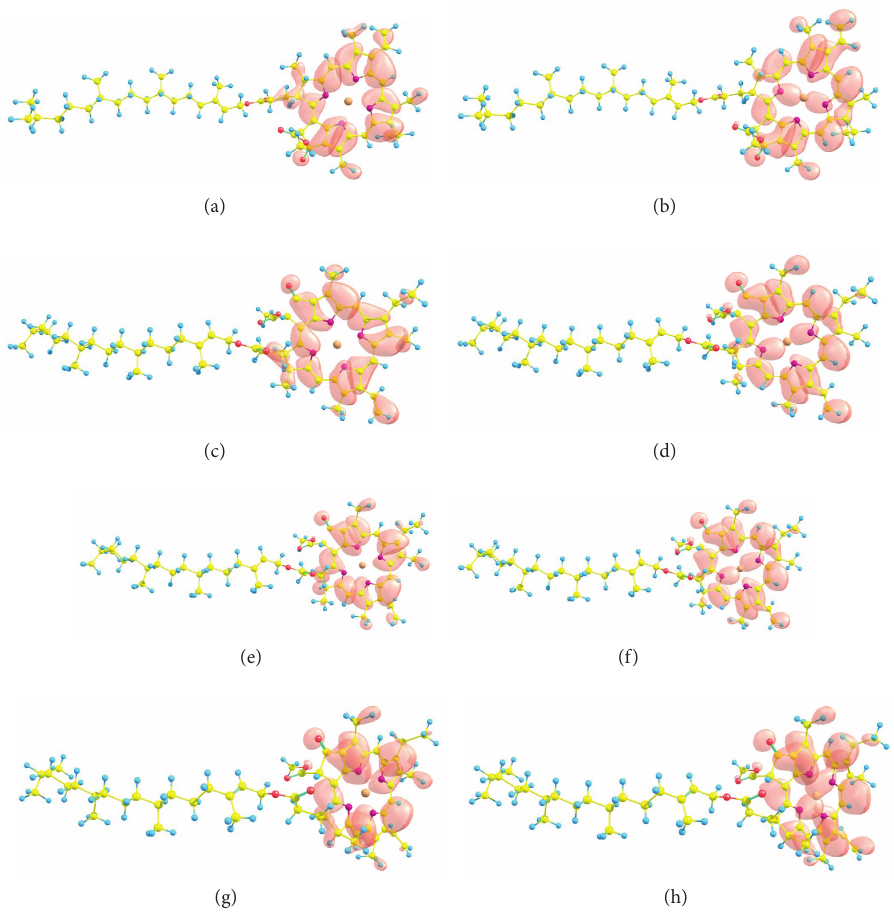
F 4: HOMO and LUMO orbitals of the chlorophyll a molecule calculated with the M06, M06L, M06-2X, and M06-HF density functionals and the MIDIY and DGDZVP basis